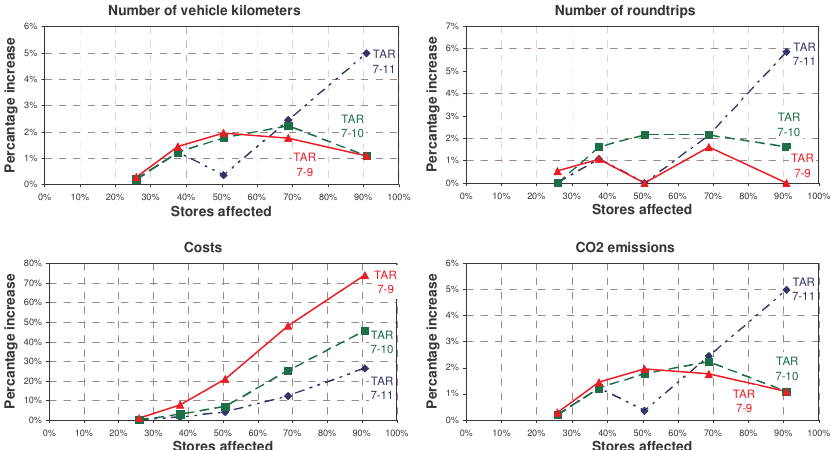
Figure 8. Values for FR3 and the time access restriction policy